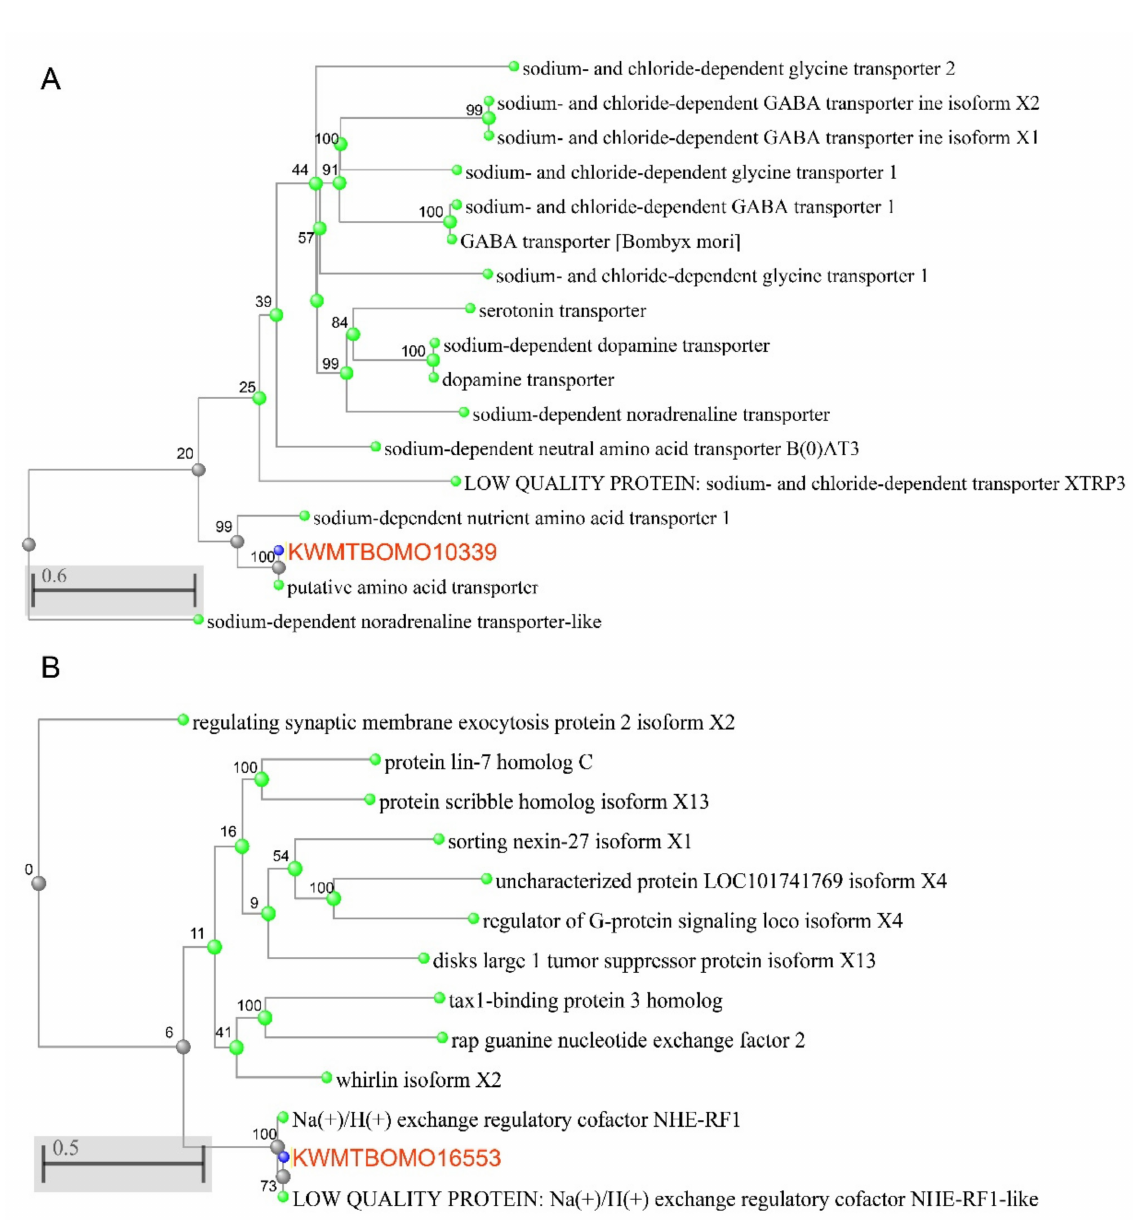
Figure 6. The phylogenetic tree analysis of yellow blood suppressor genes. ( A ) Phylogenetic tree of KWMTBOMO10339 and other homologous proteins from B. mori ; ( B ) Phylogenetic tree of KWMT- BOMO16553 and other homologous proteins from B. mori